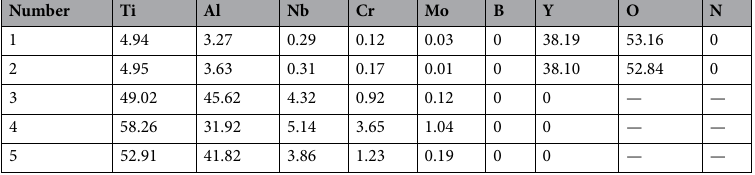
Table 1. Elemental composition (at.%) determined via EPMA at points 1–5 in Fig.